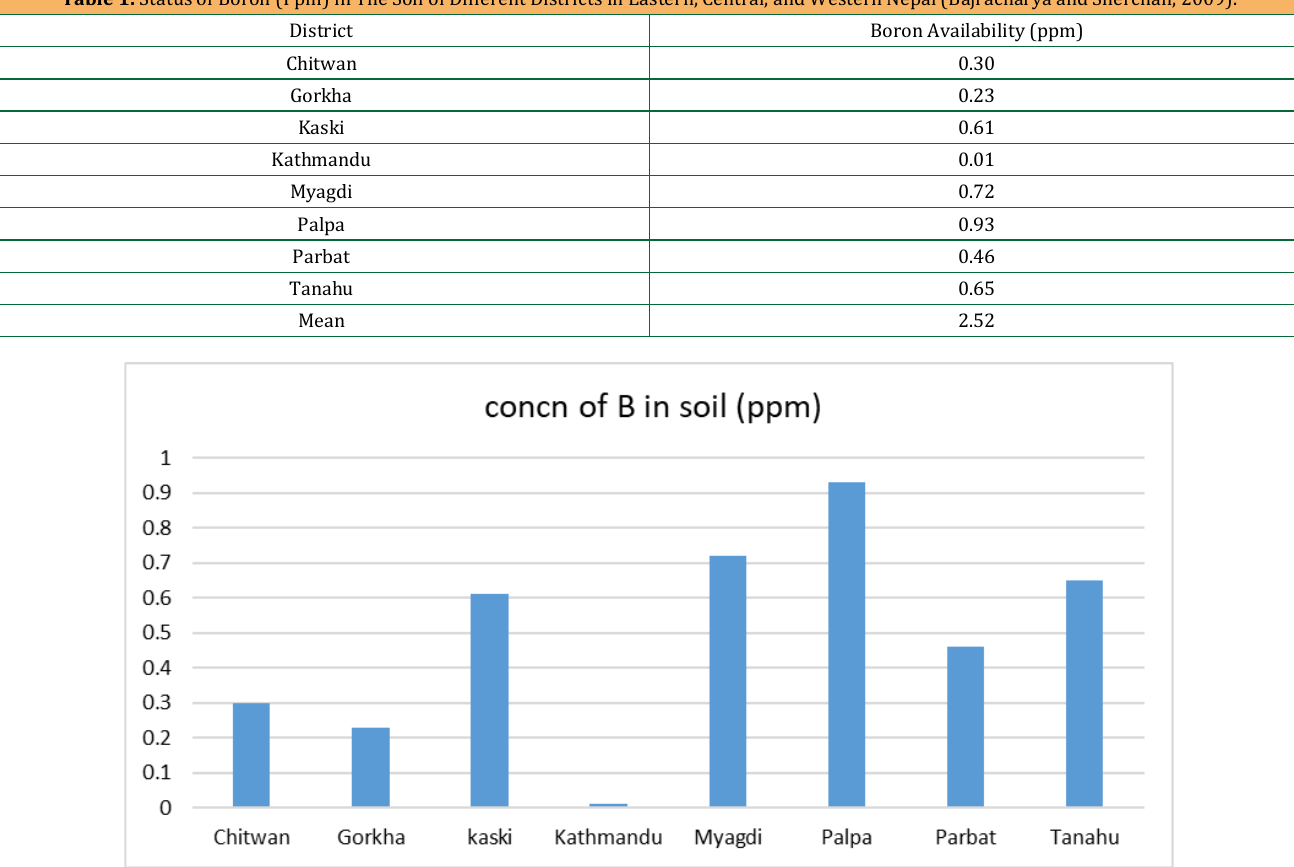
Table 1: Status of Boron (Ppm) in The Soil of Different Districts in Eastern, Central, and Western Nepal (Bajracharya and Sherchan, 2009).